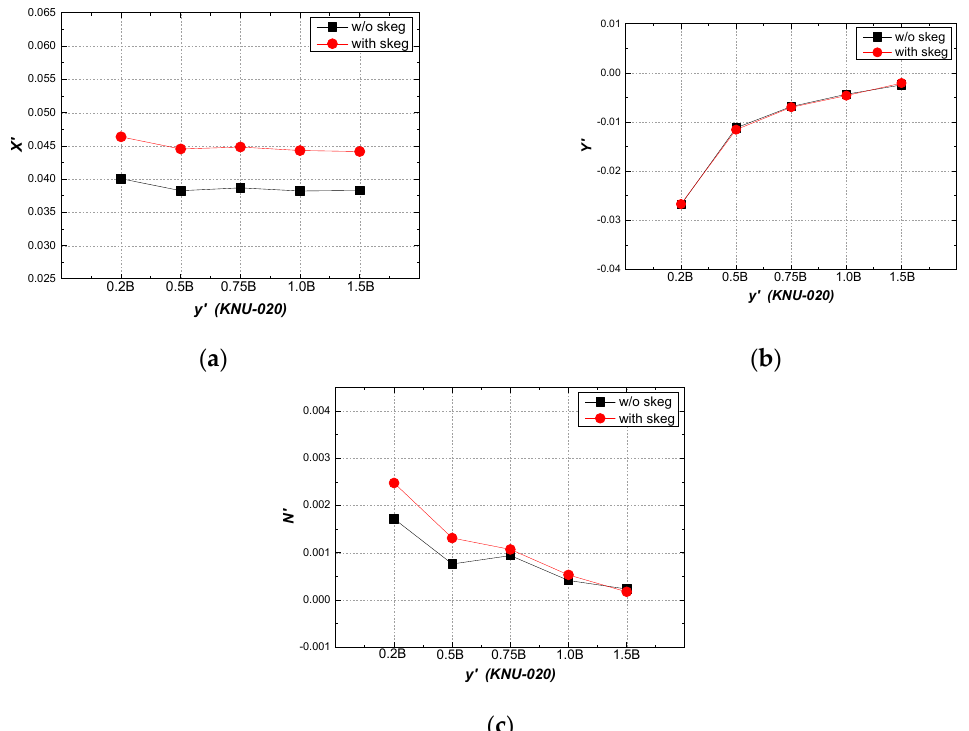
Figure 4. ( a ) Dimensionless surge force X’ , ( b ) sway force Y’ and ( c ) yaw moment N’ on KNU-020, according to the barge–bank distance.